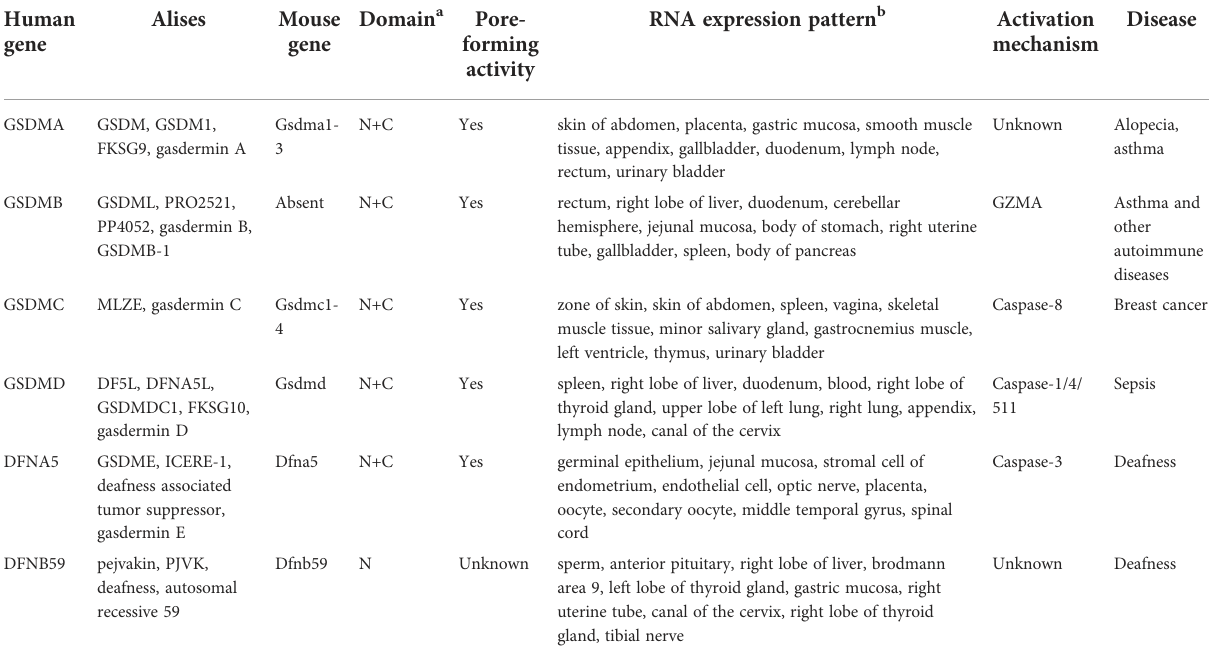
TABLE 1 Properties and functions of gasdermin family proteins. Human